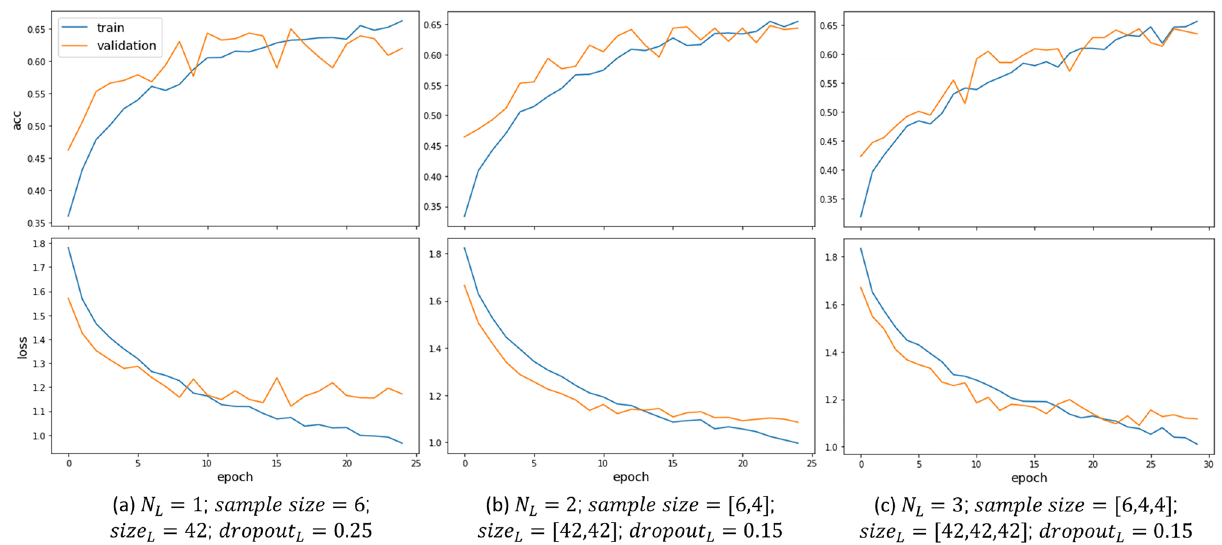
Figure 6. Learning curves of aggregator functions with different hidden layer counts ( N L ) and tuned